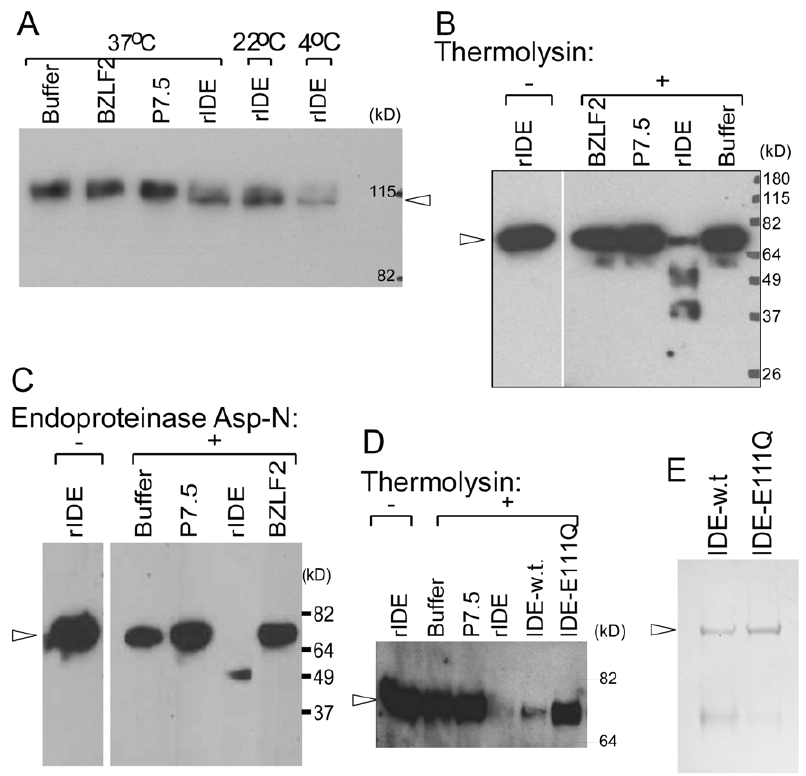
Figure 5. rIDE modifies gEt and induces a conformational change in gEt. (A) Biotin labeled gEt-Fc protein (arrow) was incubated with rIDE at the indicated temperature for 30 min. After electrophoresis and transfer onto a nitrocellulose membrane, proteins were visualized with streptavidin- conjugated-horse radish peroxidase. (B) Biotin-labeled gEt-His protein (arrow) was incubated with buffer, control protein BZLF2 or P7.5, rIDE (produced in baculovirus) at 37 u C for 30 min, followed by urea for 18 hr and thermolysin for 30 sec. The proteins were separated by electropheresis, transferred to a nitrocellulose membrane and proteins were detected using streptavidin-conjugated horse radish peroxidase. (C) Biotin-labeled gEt- His protein (arrow) was incubated with rIDE or control proteins at 37 u C for 30 min, followed by incubation with 4 m g/ml of endoproteinase Asp-N (Roche Applied Science, Indianapolis, IN) at 37 u C for 45 sec. The digestion was then terminated by adding 0.5 M EDTA and samples were boiled in SDS-PAGE gel loading buffer with 2.5% 2-mercaptoethanol and separated by electrophoresis. Protein fragments were detected by streptavidin conjugated-horse radish peroxidase. (D) Binding of catalytically inactive IDE mutant protein IDE-E111Q to gEt fails to induce a conformational change in gE. Biotin-labeled gEt-His protein (arrow) was incubated with rIDE (produced by baculovirus), IDE-E111Q (produced in bacteria), or IDE-w. t. (produced in bacteria), or negative control proteins as indicated at 37 u C for 30 min, followed by thermolysin and processed as described in panel B. (E) Coomassie Blue stained SDS-PAGE gel showing the amount of IDE-E111Q and IDE-w.t. proteins used for pulse proteolysis assay in panel